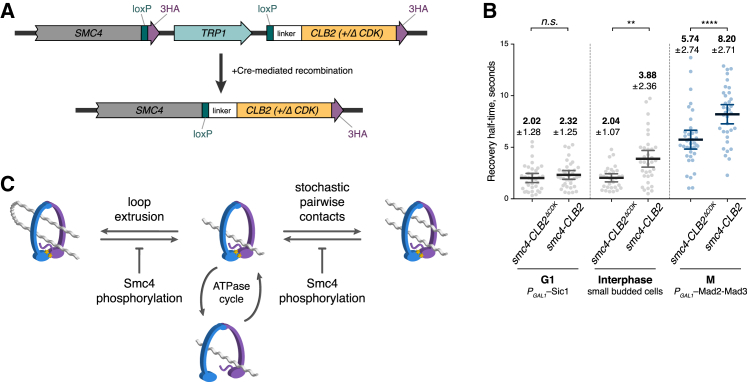
Smc4 Phosphorylation Regulates Condensin Dynamics and Chromosome Condensation(A) Schematic representation of the gene loci expressing Smc4-Clb2 and Smc4-Clb2ΔCdk fusion proteins.(B) Fluorescence recovery half-times, following photobleaching, of the Brn1-3mNeonGreen signal in homozygous diploid SMC4-CLB2ΔCDK and SMC4-CLB2 cells in interphase and metaphase. Error bars represent mean ± SD (n ≥ 31) (ordinary one-way ANOVA, Sidak’s multiple comparison test).(C) Model of chromosome condensation driven by cell-cycle-regulated Smc4 phosphorylation, resulting in stabilization of condensin-DNA binding. This promotes chromosome compaction if the condensation reaction proceeds by either diffusion capture or loop extrusion.See also Figure S6 for additional condensin dynamics, phosphorylation, and chromosome condensation assays.